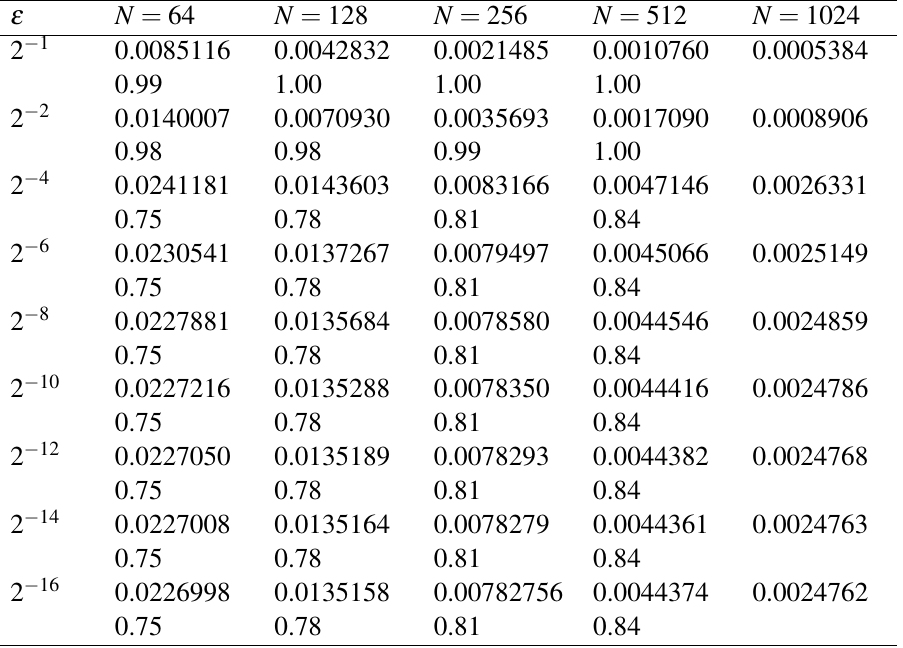
Table 1 Maximum errors and rates of convergence on ω N , 1